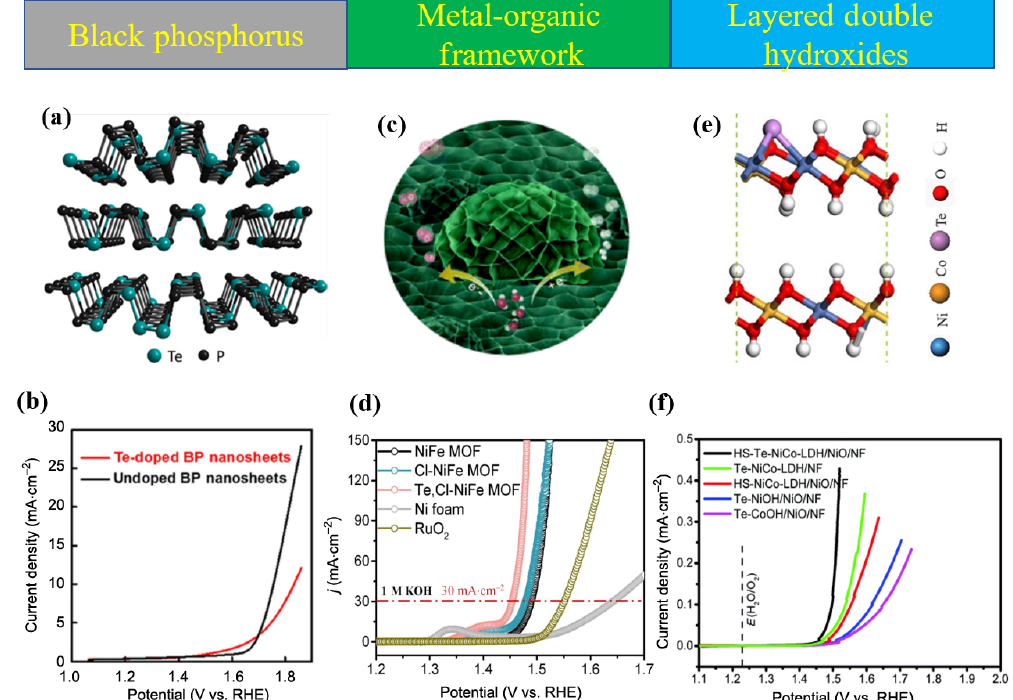
Figure 1 (a) Model of Te doped 2D BP. Black atoms represent BP, and blue atoms represent Te. (b) The LSV curves of the few-layer undoped and Te-doped BP nanosheets in 1 M KOH. (c) Model of MOF. It has a high specific surface area, which is beneficial to OER. (d) The LSV curves of the Te, Cl co-doped in 1 M KOH. (e) Model of Te doped NiCo-LDH. Purple atoms represent Te. (f) The LSV curves of the Te doped NiCo-LDH in 1 M KOH. Panels (a) and (b): reproduced with permission from Ref. [62], © American Chemical Society 2018. Panel (c): reproduced with permission from Ref. [64], © the Partner Organisations 2021. Panel (d): reproduced with permission from Ref. [65], © Elsevier B. V. 2022. Panels (e) and (f): reproduced with permission from Ref. [79], © Zhang, D. et al.